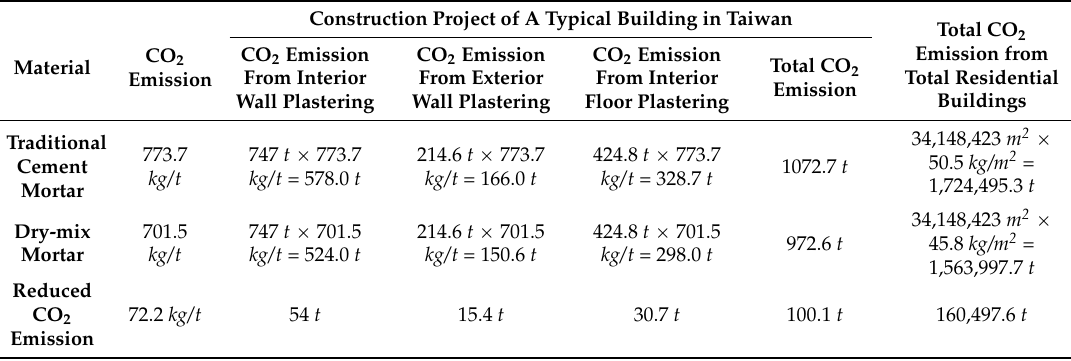
Table 1. CO 2 Emission Comparison between Traditional Cement Mortar and Dry-mix Mortar.